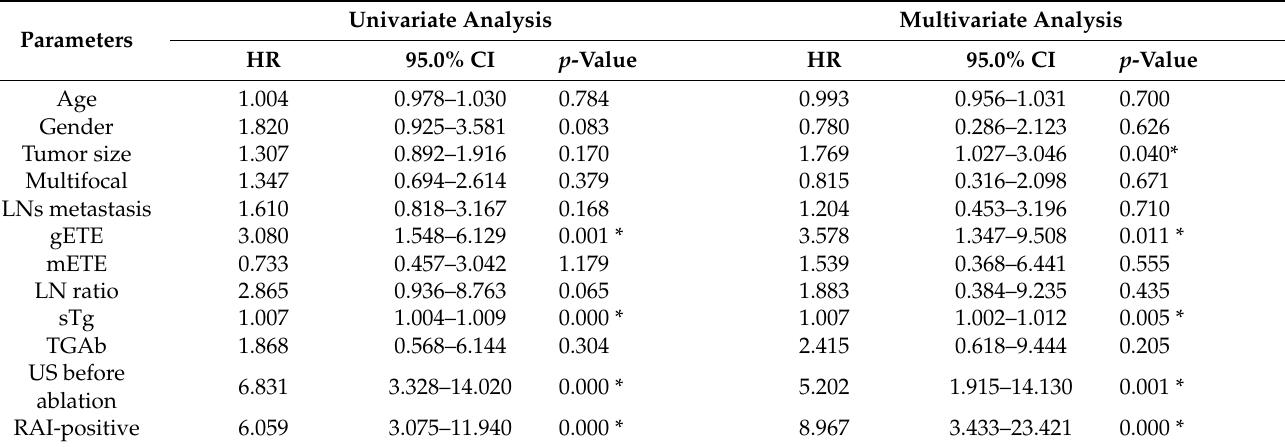
Table 4. Clinical factors associated with the RFS by Cox regression analysis.